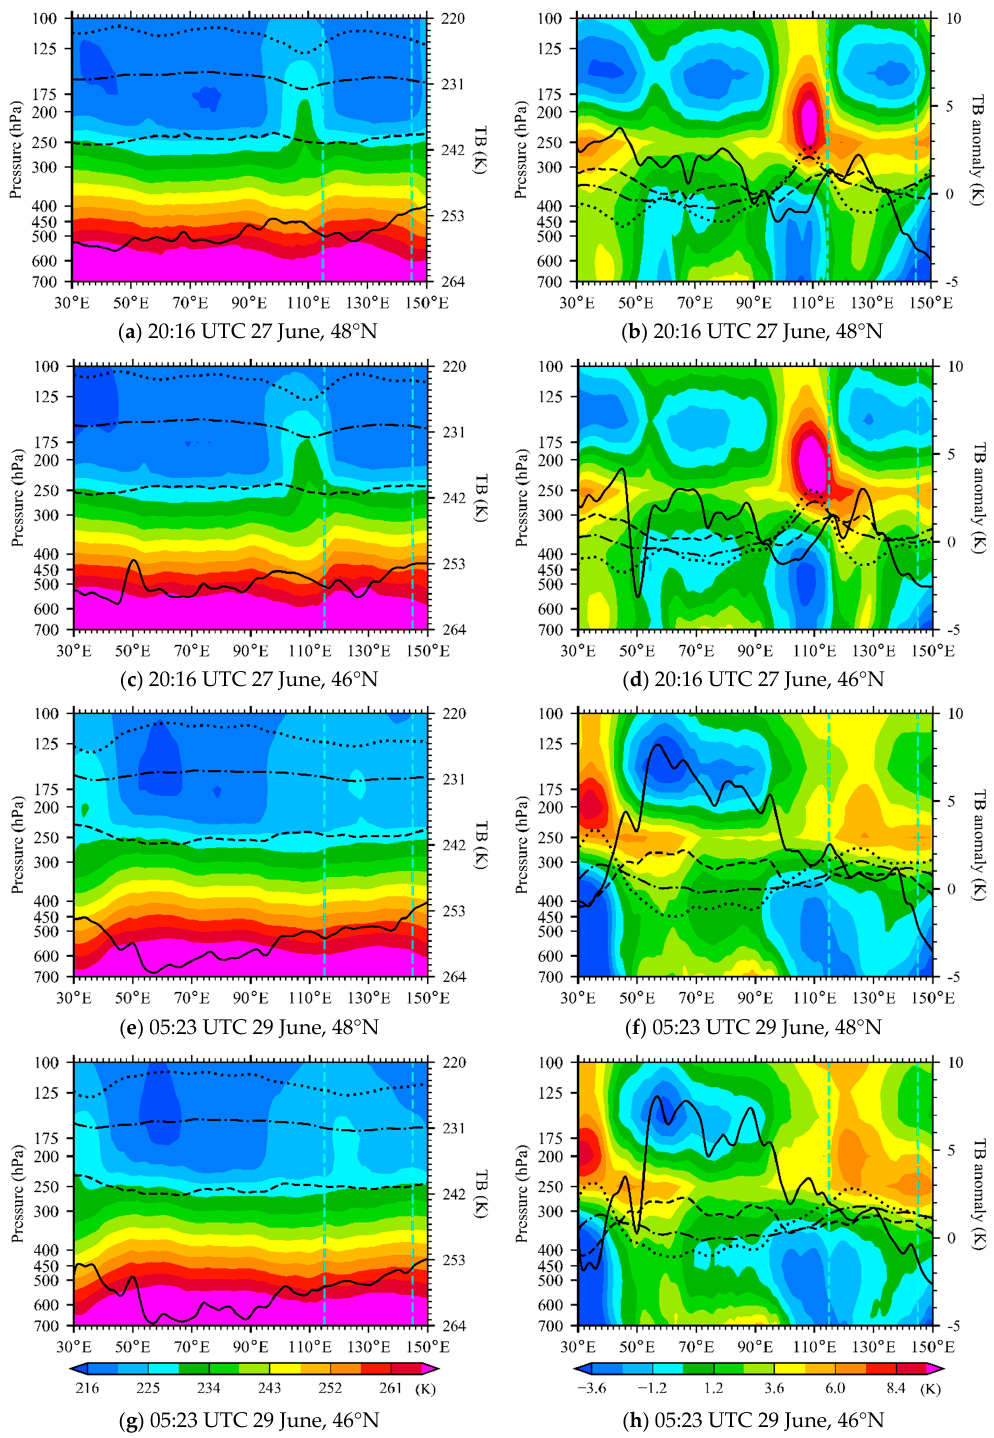
Figure 10. West–east cross-sections of (left panels) temperatures and (right panels) temperature anomalies (shaded, unit: K) from ERA5 reanalysis, with black curves indicating (left panels) bright- ness temperatures and (right panels) brightness temperature anomalies of MWTS-2 channels 4 (solid), 5 (dashed), 6 (dash-dotted), and 7 (dotted) at 48°N and 46°N from 27 to 29 June 2019. The anomalies are calculated with respect to zonal means of each level (or channel) at the given latitude of data from 21 to 29 June 2019. The zonal means of MWTS-2 channels 4, 5, 6, and 7 at latitude 48°N are 255.1, 239.7, 229.8, and 223.2 K, while at 46°N, the means are 255.6, 239.9, 229.7, and 222.6 K. Temperature and TB anomalies are illustrated in the right panel of Figure 10, which amplifies the TB features of the cutoff low. It can be clearly seen that there was an obvious negative temperature anomaly at 450–700 hPa and an obvious positive temperature anomaly at 100–300 hPa near 110 ° E. At 18:00 UTC 27 June, TB observations of channels 6– 7 had positive anomalies of 2–3 K, while those of channels 4–5 had negative anomalies around − 1 K. In Figure 10f,h, the cutoff low had entered the NCCV domain at 06:00 UTC